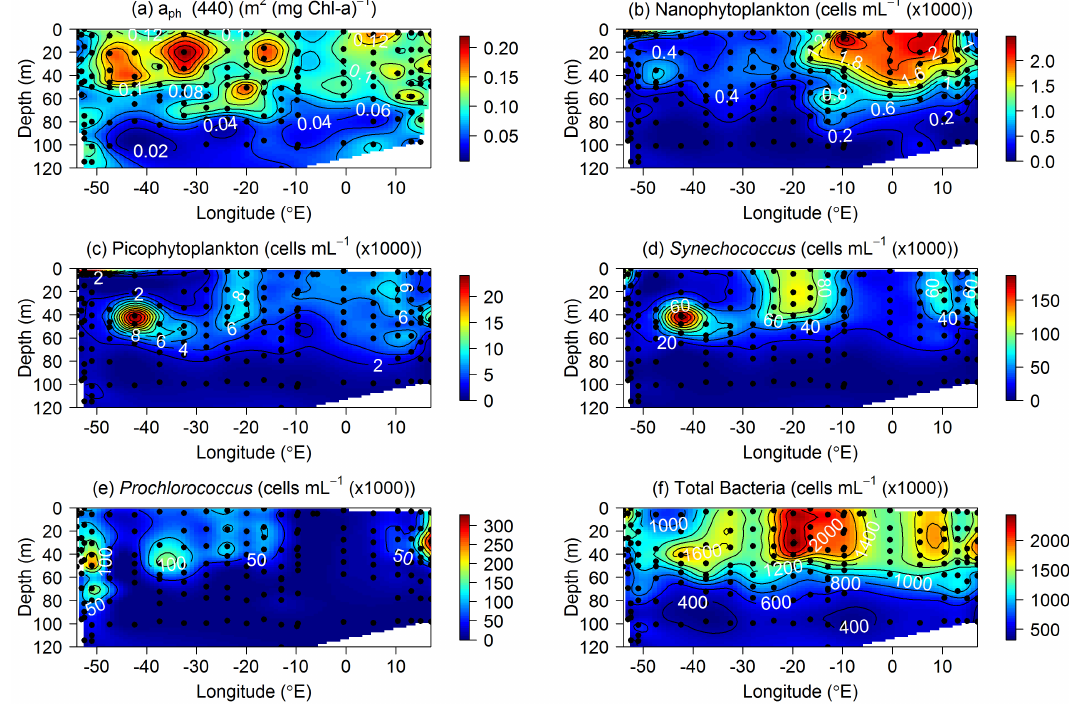
Fig. 4. Cross-basin (depth-longitude) sections of (a) specific phytoplankton absorption at 440nm, and analytical flow cytometry counts of: (b) nanophytoplankton; (c) picophytoplankton; (d) Synechococcus ; (e) Prochlorococcus ; (f) total